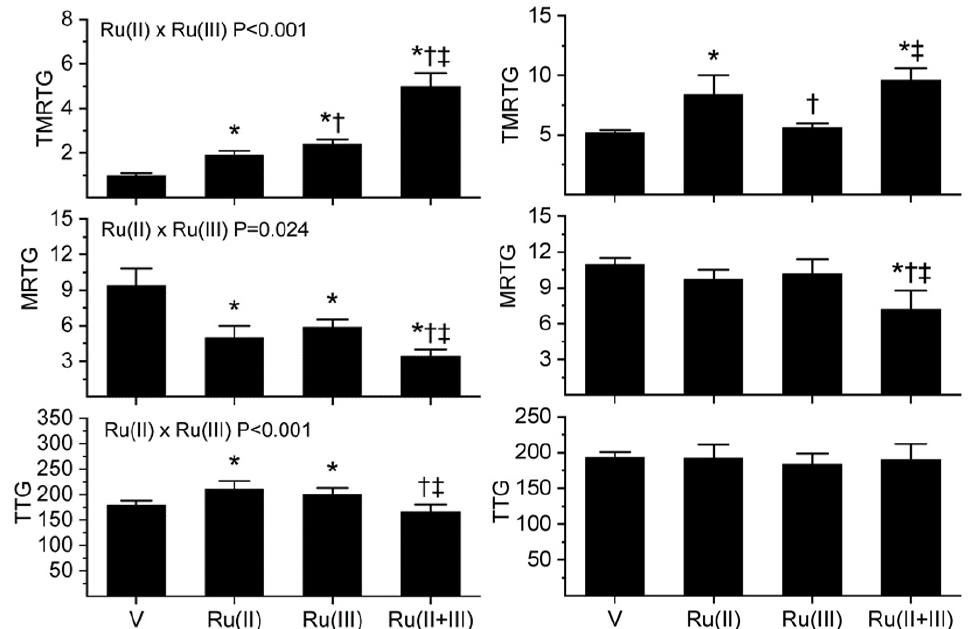
Figure 5. Procoagulant activity of P. textilis venom (left panels) and H. suspectum venom (right panels) in plasma after exposure to CORM-3 (Ru(II)), RuCl 3 (Ru(III)) or both (Ru(II + III)) in isolation. Data is presented as mean ± SD. V = venom; Ru(II) = V + CORM-3 in PBS; Ru(III) = V + RuCl 3 ; Ru(II + III) = V + CORM-3 and RuCl 3 . * p < 0.05 vs. V; † p < 0.05 vs. Ru(II); ‡ p < 0.05 vs. Ru(III). Significant interactions between CORM-3 and RuCl 3 (Ru(II) × Ru(III)) determined with two-way ANOVA are displayed within individual parameter graphics.